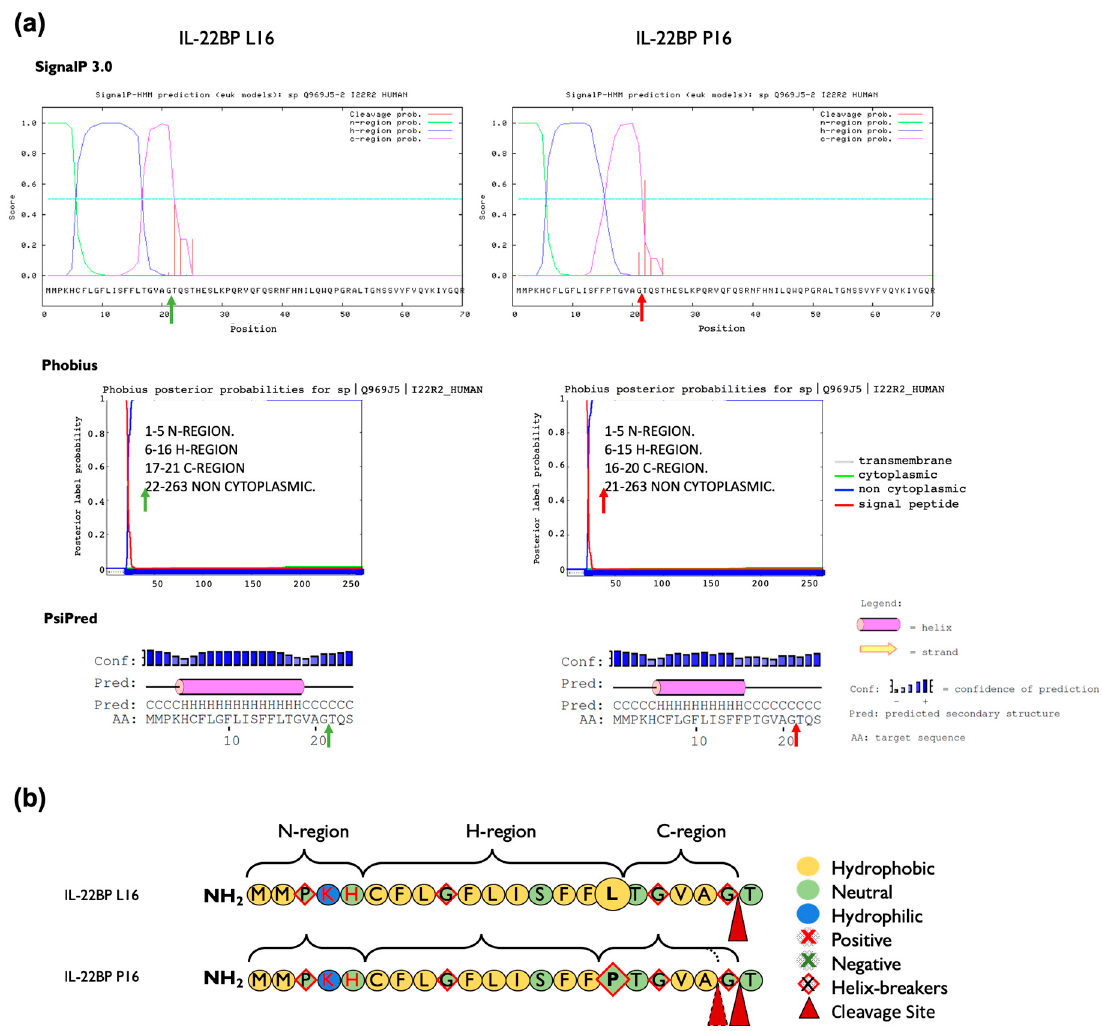
Figure 3. Prediction of the effect of the p.Leu16Pro amino acid change on the IL-22BP signal peptide structure and cleavage site of mature IL-22BP. ( a ) The signal peptide cleavage site indicated with green (wt, Leu16) or red (Pro16) arrows, was predicted using SignalP-3.0, Phobius and PsiPred software. The cleavage site for the canonical sequence is predicted to occur between positions 21 and 22 by the three software applications used. The p.Leu16Pro variant causes a shift in the predicted cleavage site to between position 20 and 21 according to Phobius but not SignalP 3.0 and PsiPred each of which predicted identical cleavage sites to the canonical sequence. All software coincided in predicting a decrease in the length of the H-region in the mutant form. ( b ) Representation of the composition, hydrophobicity and charge of the amino acids that comprise the signal peptide of IL-22BP. The three domain structures of the IL-22BP signal peptide are represented based on the overall results obtained in ( a ), and consist of the N-region, a hydrophilic positively charged N-terminal region; the H-region, a hydrophobic core region; and the C-region, a polar uncharged C-terminal region that is recognized by signal